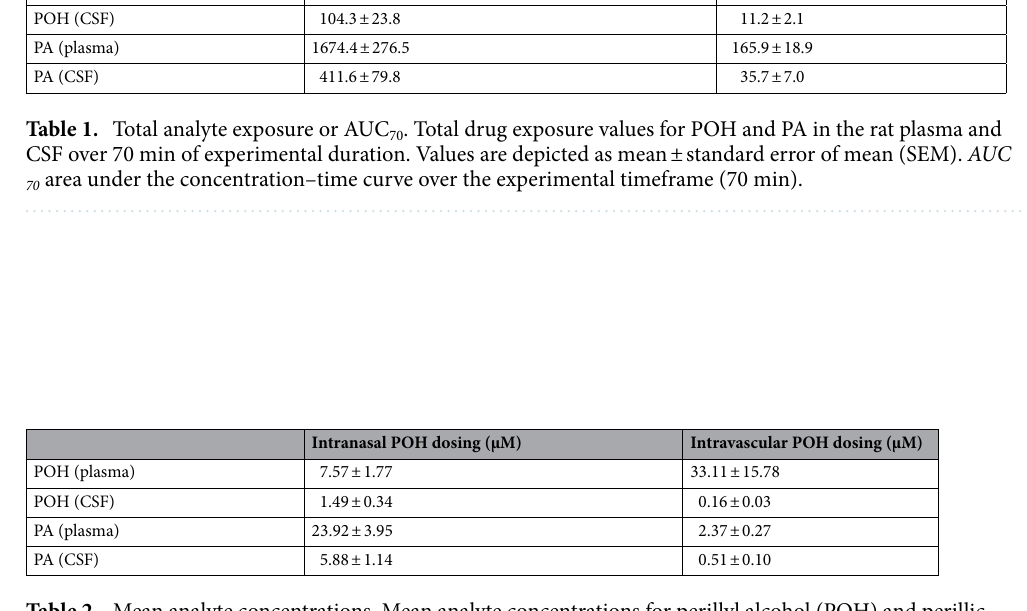
Table 2. Mean analyte concentrations. Mean analyte concentrations for perillyl alcohol (POH) and perillic acid (PA) in the rat plasma and cerebrospinal fluid (CSF). Values are depicted as mean ± standard error of mean